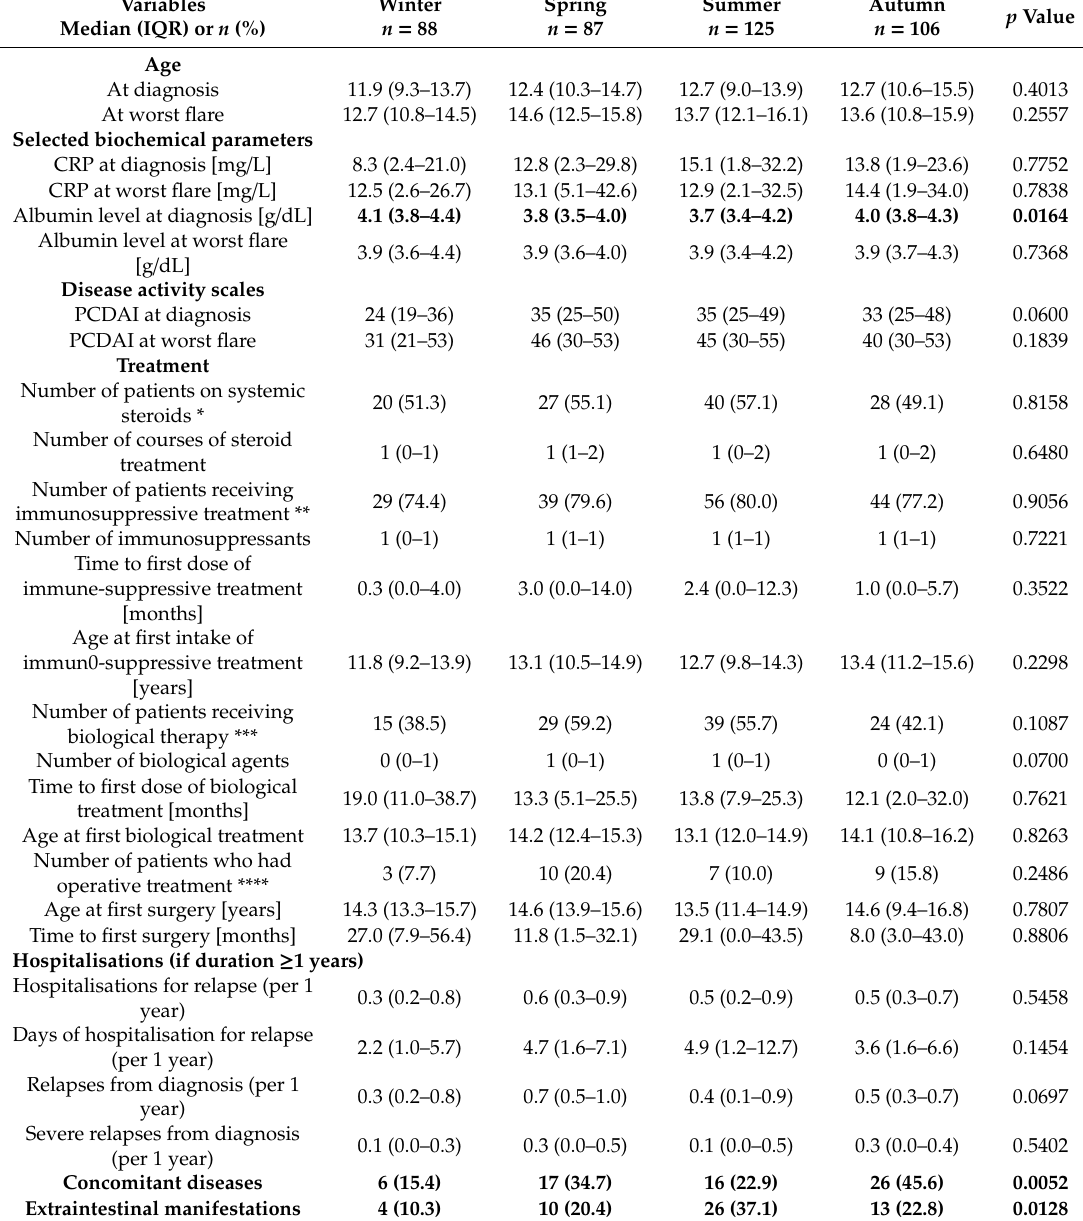
Table 2. Clinical characteristics of patients with Crohn’s disease depending on the season of diagnosis. Variables Median (IQR) or n